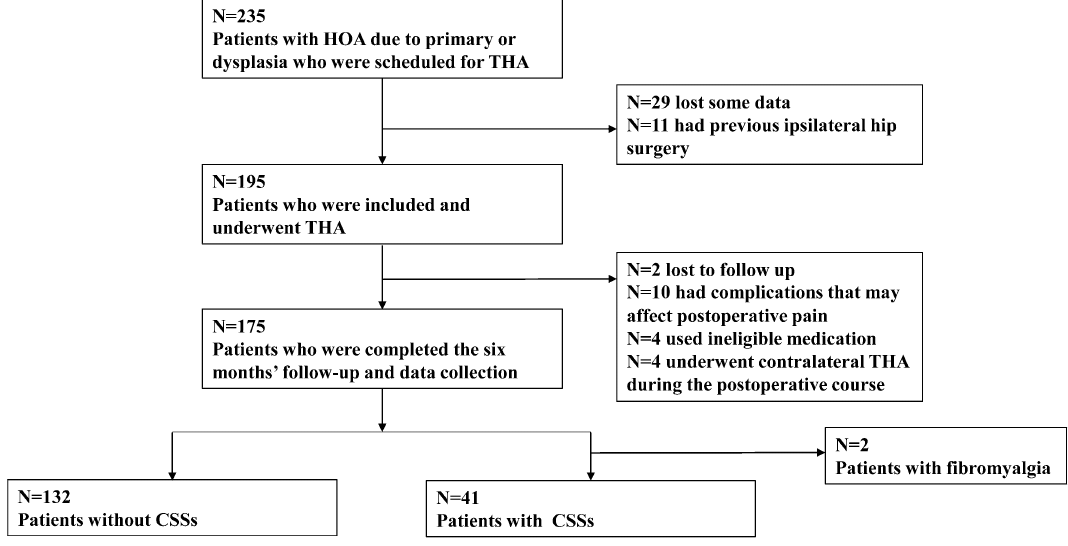
Figure 1. Flowchart of the study. HOA hip osteoarthritis, THA total hip arthroplasty, CSS central sensitivity